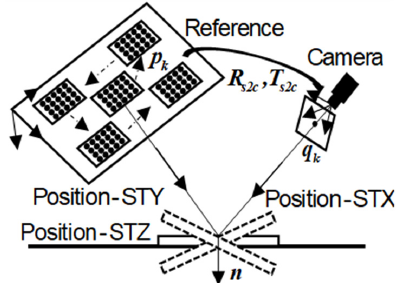
Figure 2. Structure of measurement system. The calibration grid moves on the reference plane for M times. A feature point P k of the grid is reflected in the image point q via the mirror at position k STX, STY, STZ. We can obtain three calibration images at each grid location. Then, W × 3 calibration images can calculate the intrinsic matrix A , as well as the pose parameters R ji and T ji . Finally, R s 2 c , T s 2 c , n , and d can be calculated by Equations (8) and